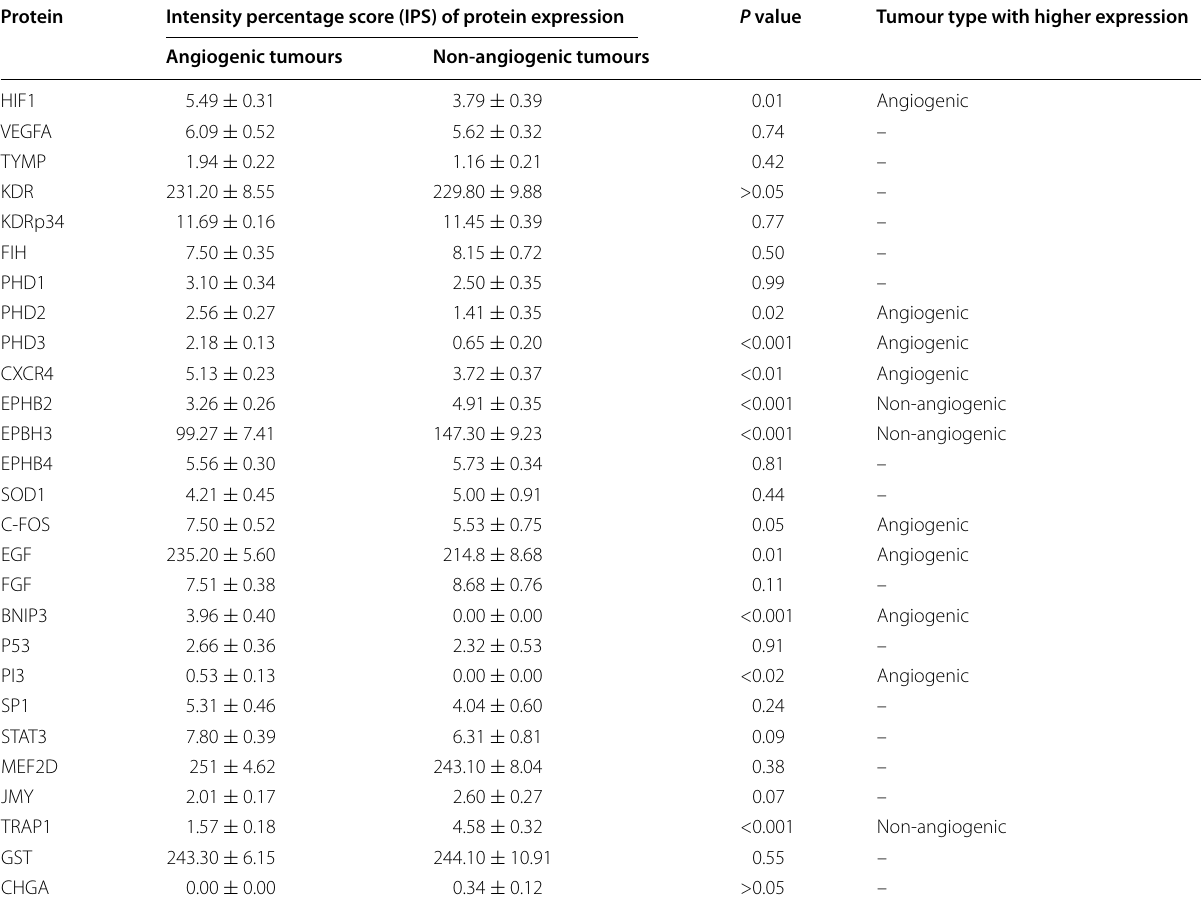
Table 5 Nuclear expression of the proteins in angiogenic versus non-angiogenic NSCLCs